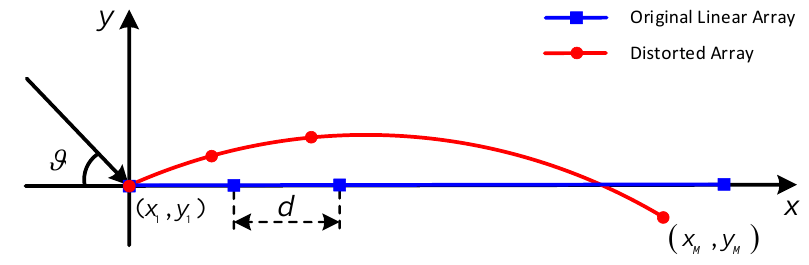
Figure 1. Shape distortion of a towed hydrophone